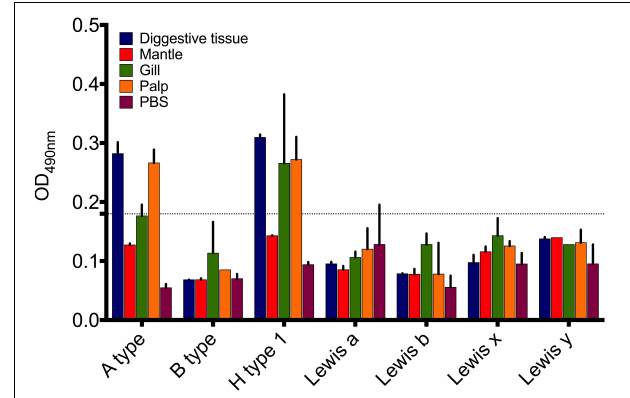
FIGURE 2 | Expression of HBGA-like molecules in digestive tissues, gills, mantle, and palp tissue extracts of Pacific oyster. Data presented as mean ( n = 5) ±